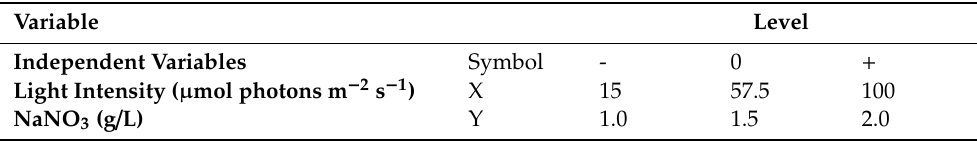
Table 4. Real and coded levels for the variables: luminous intensity and nitrogen levels (NaNO 3 ) in the cultivation of